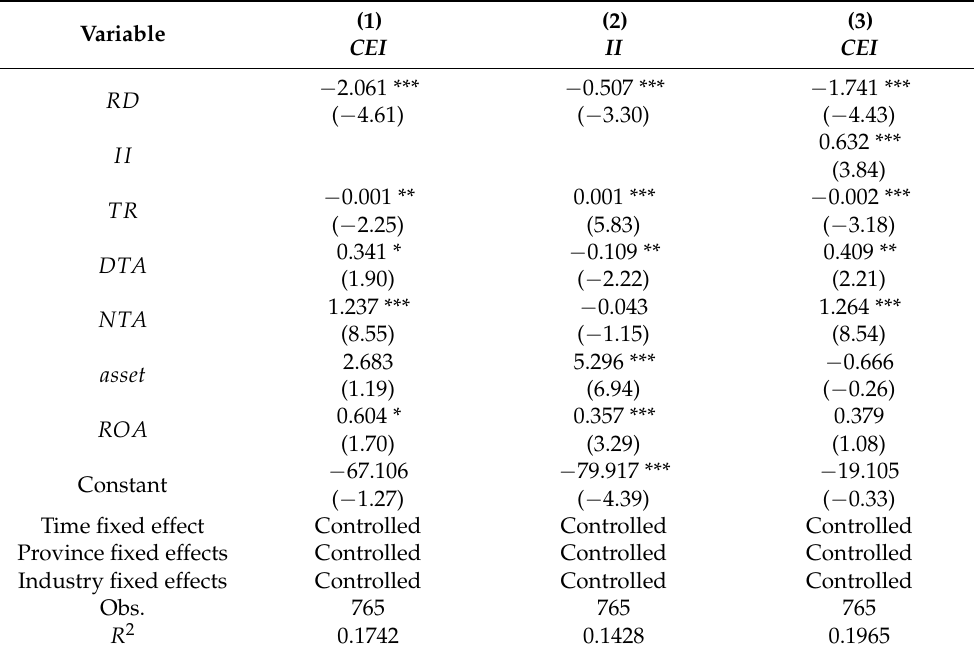
Table 6. The benchmark regression and mediating effect results.